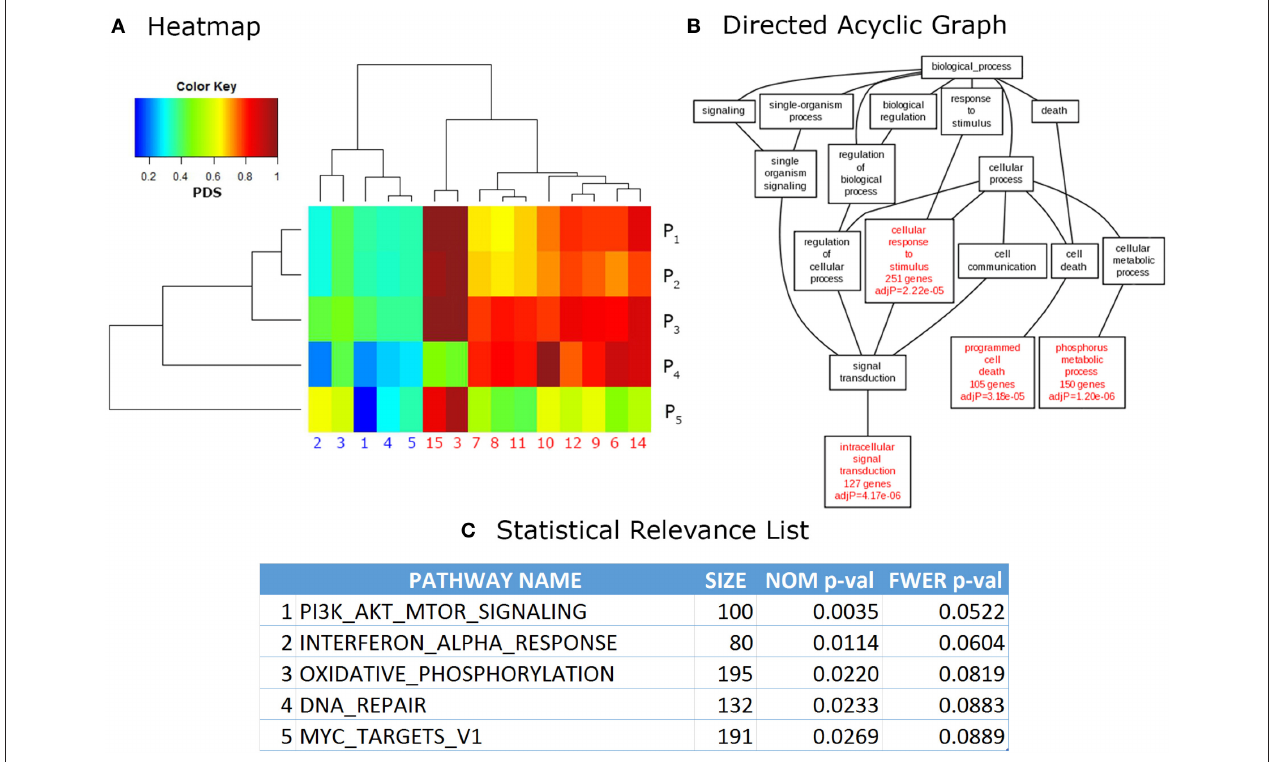
FIGURE 2 | Common outputs of PA tools. (A) Heatmap. Each cell of a heatmap represents a numerical value with a color code. In this case lower values are represented in blue, while higher values turn to red. This example shows data analyzed with Pathifier (Drier et al., 2013), the phenotypic information for data used in these calculations is irrelevant, it was used only for illustrative purposes. (B) Directed Acyclic Graph (DAG). DAGs can be used to represent partially ordered items. In this case, relevant GO categories are highlighted in red with their respective confidence values. This DAG is a partial result from the example data provided in WebGestalt ( Zhang et al., 2005) website. (C) Statistical Relevance List. This kind of lists is the most common output in PA methods. In it, the statistical significance of the top pathways ranked on their p -values (NOM = nominal, FWER = Family wise error rate corrected, Size = size of the pathway) is shown. This is an example